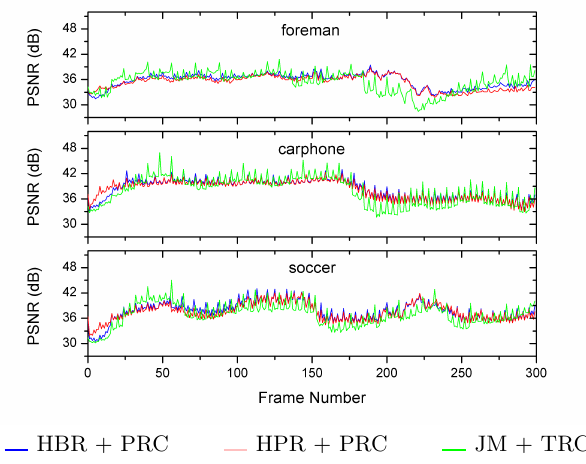
Fig. 4: PSNR curves for CIF Test